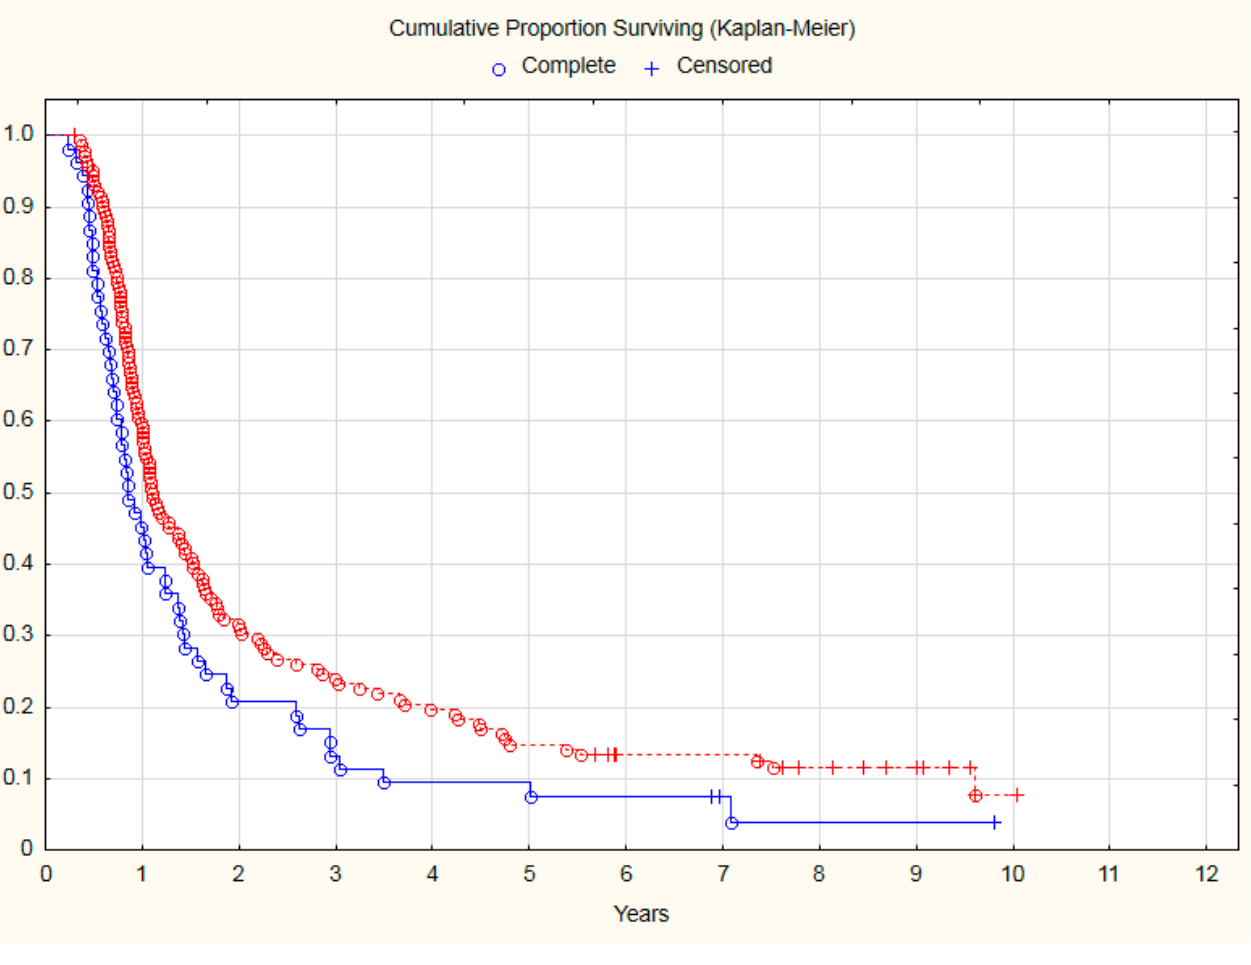
Figure 2. The comparison of PFS between NSCLC patients with KPS deterioration during chemoradiotherapy (blue line) and patients with stable performance status (red line). Median of PFS: 10.27 months vs. 13.33 months. Risk of NSCLC progression: HR = 1.44; 95% CI: 1.03–1.99; p = 0.03. Table 2. Demographic and cancer-related factors affecting the deterioration of KPS during sequential chemotherapy and radiotherapy. Prognostic